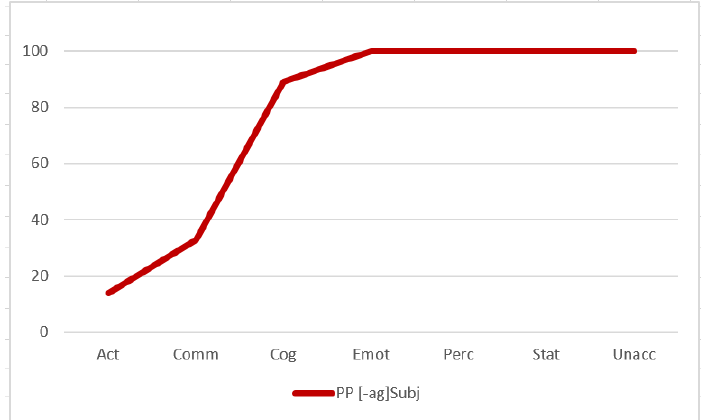
Source : Data extracted from